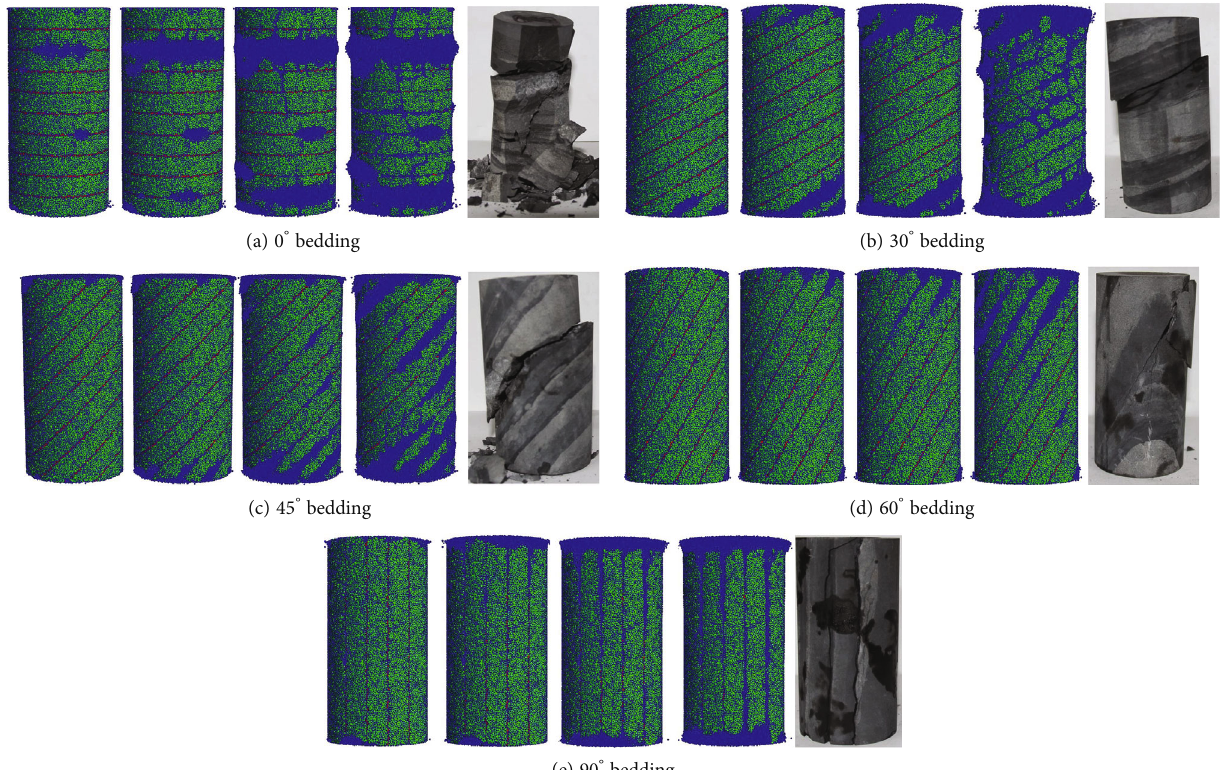
Figure 11: Schematic diagram of failure process of samples and models under di ff erent bedding inclination angles.